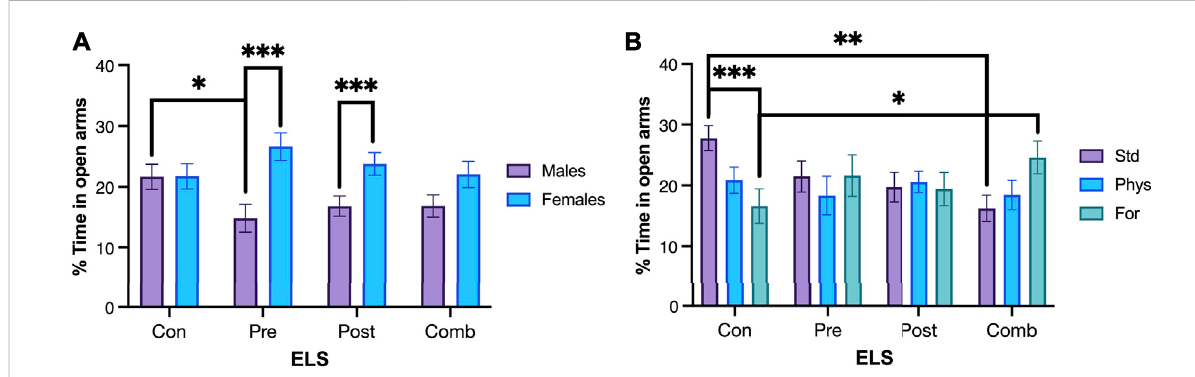
FIGURE 4 Percentage of time spent inopen arms. (A) Control males (n = 29) spent more time in theopen arms comparedwith males exposed to prenatal ELS(n=31).FemalesexposedtoprenatalELS(n=28)spentmoretimeintheopenarmscomparedtomalesexposedtoprenatalELS(n=31).Females exposed to postnatal ELS (n =26) spent more time in theopen arms compared to males exposed to postnatal ELS (n = 33). (B) Control animals spent lesstimeintheopenarmswhentheywerehousedwithForaging-EE(n=19)comparedtostandardhousing(n=19).Ratsexposedtocombined ELS with standard housing (n = 19) spent less time in the open arms compared to controls (n = 19). Animals exposed to combined ELS and housed with Foraging-EE (n = 18) spent more time in the open arms compared to controls housed with the same Foraging-EE (n = 19). Abbreviations: ELS, Early life stress; Con, Control; Pre, Prenatal; Post, Postnatal; Comb, Combined; EE: Std, Standard; Phys, Physical-EE; For, Foraging-EE. Three Way ANOVA (see Table 1 for statistical results): *** p < 0.001, ** p < 0.01, * p <